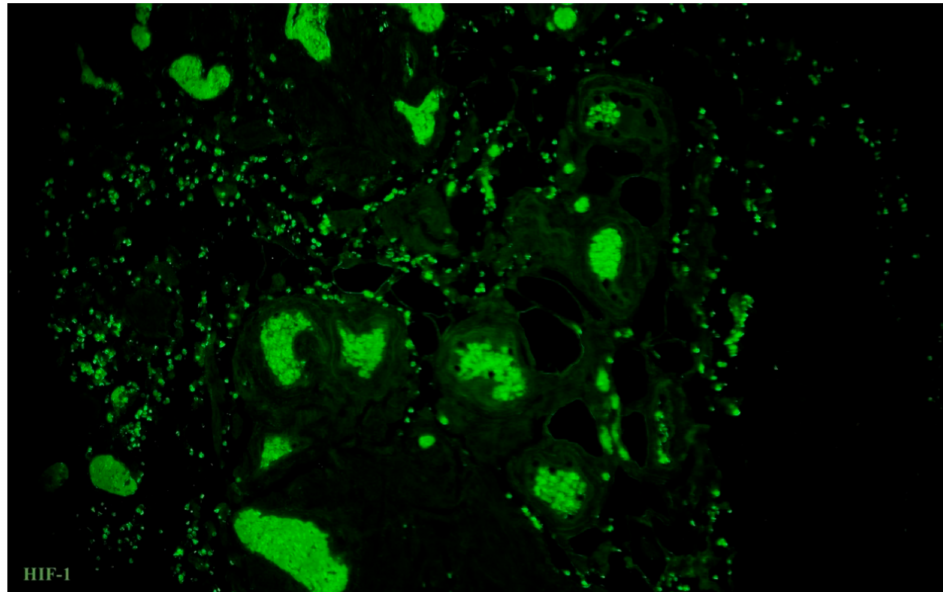
Figure 12. Tissue samples from the ampulla of the human oviduct stained for hypoxia-inducible factor (HIF)-1 (green, Alexa Fluor 488). High expression of HIF-1 was common for all layers of the oviduct in tissue samples from the control group, slightly dominated in outer layers in comparison to the inner. Total magnification: ×